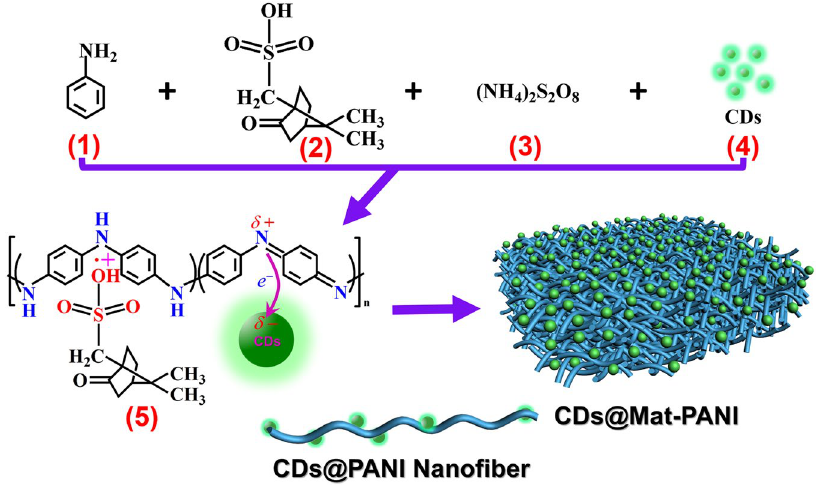
Figure 1. An illustration of the synthesis procedure of